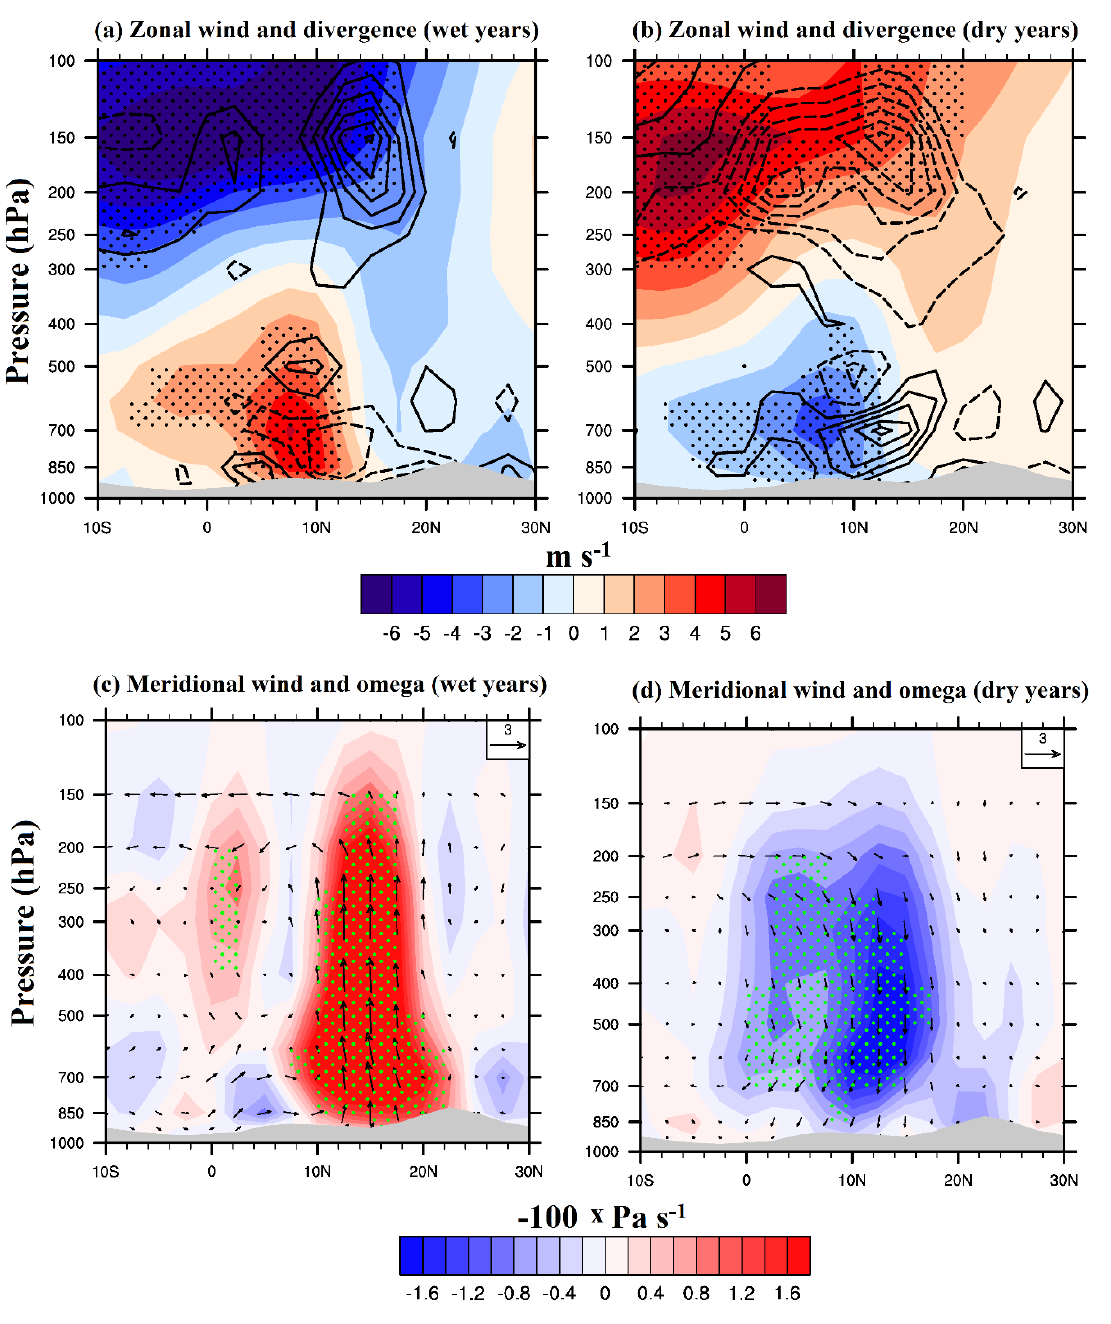
Figure 4. Anomalies of zonal wind (shaded; m s −1 ) and divergence (contours; m s −1 ) in ( a ) wet years and ( b ) dry years. Latitude–height cross section of Hadley circulation anomalies for ( c ) wet years and ( d ) dry years. The circulation consists of meridional (m s −1 ) and vertical velocity (−100 × Pa s −1 ). Values under the topography are masked gray. Stippling indicates regions where anomalies are significant at the 95% level.